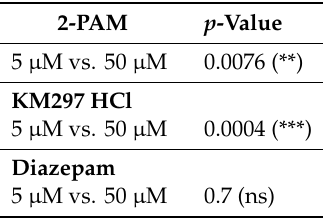
Table 5. The statistical comparison performed by a nonparametric Mann–Whitney test of the Pe values at 5 and 50 µ M for 2-PAM, KM297 HCl, and